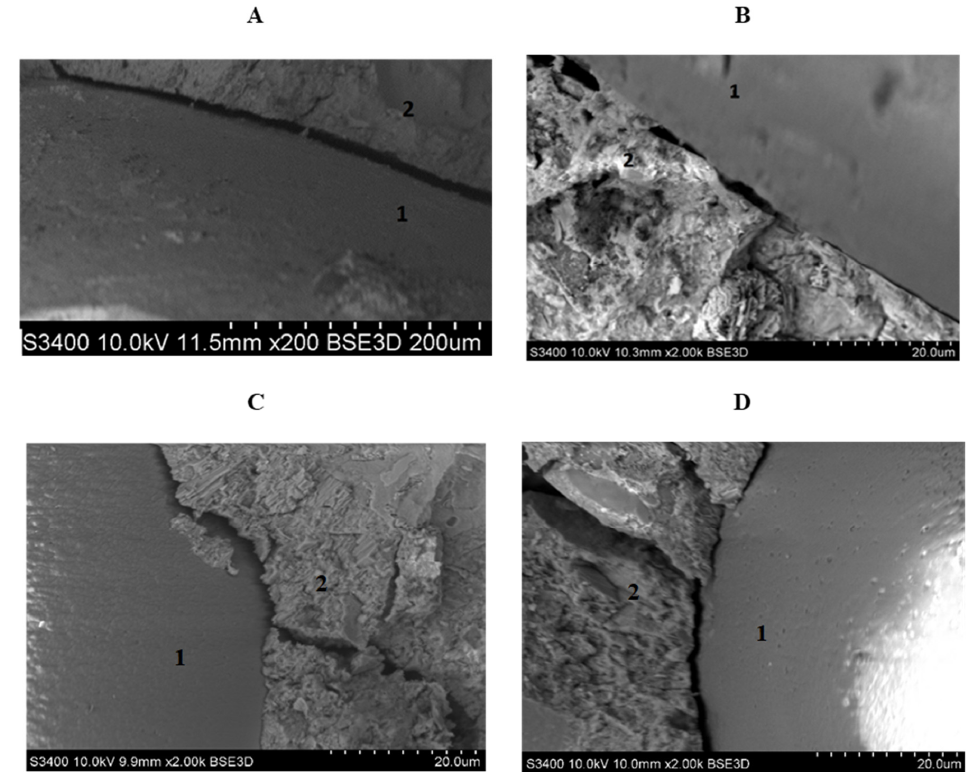
Figure 7. SEM image of cement mortar after 28 days. 1—aggregate, 2—cement slurry: ( A ) without bio-admixtures (200 × magnification), ( B ) with the addition of d2 (magnification 2000 × ), ( C ) with the addition of d3 (magnification 2000 × ), and ( D ) with the addition of d5 (magnification 2000 ×